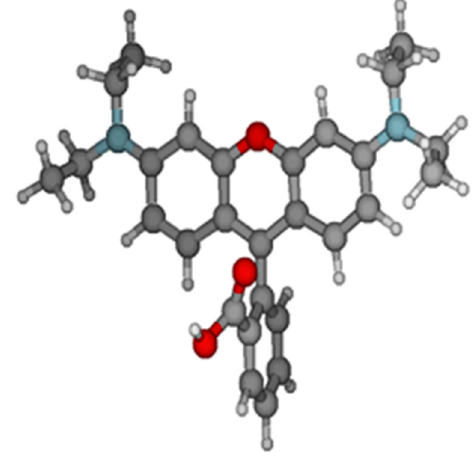
Figure 13. Ball and stick atomic model of Rhodamine B.